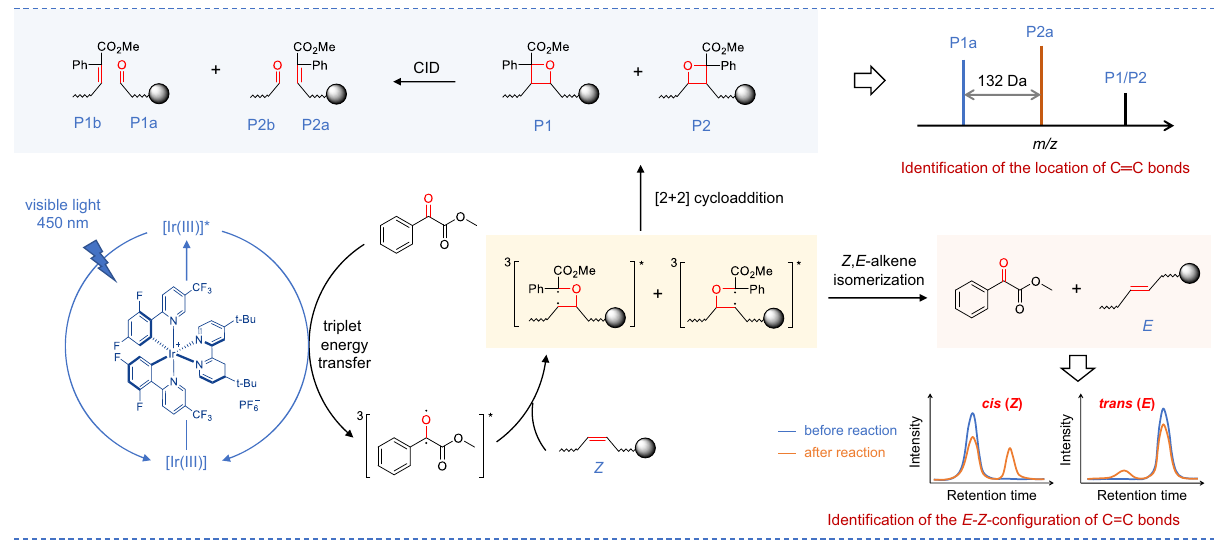
Fig. 1 Schematic illustration of the bifunctional visible-light-activated photocatalytic reaction system. For the analysis of C = C bonds positional isomer, methyl benzoylformate was excited to triplet by the photoexcited Ir[dF(CF 3 )ppy] 2 (dtbbpy)PF 6 via triplet-energy transfer. Then it underwent subsequent [2 + 2] cycloaddition with C = C bonds in lipids via the standard stepwise biradical mechanism of the Paterno ̀ − Bu ̈ chi reaction to afford oxetanes P1 and P2. The oxetane isomers could be fragmented to the diagnostic ions P1a, P1b, P2a, and P2b to indicate the locations of C = C bonds via collision-induced dissociation (CID) in tandem MS. For the analysis of E-Z isomer, the ( Z )-isomer of lipids prefers to be converted to ( E )-isomer via the triplet-energy transfer from the excited photocatalyst Ir[dF(CF 3 )ppy] 2 (dtbbpy)PF 6 in the same reaction